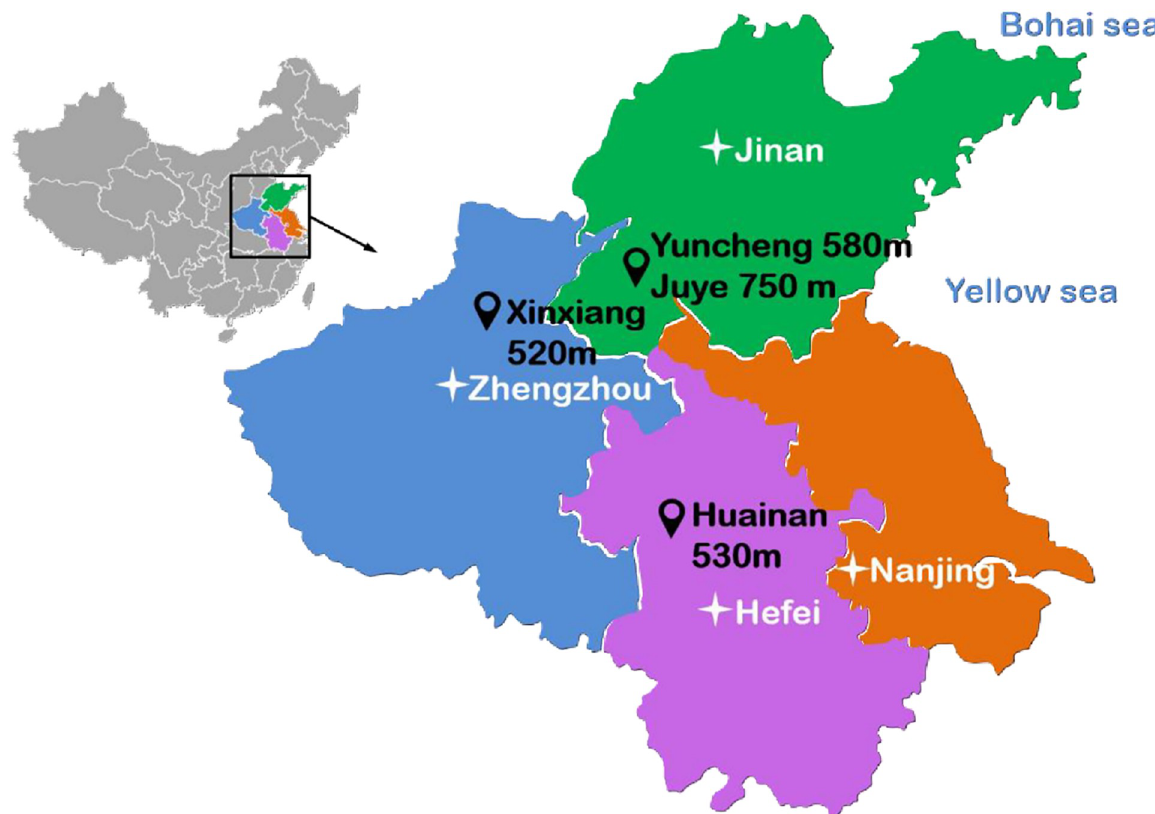
Fig 2. Some shaft linings with soil depths exceeding 500 m in the eastern region of